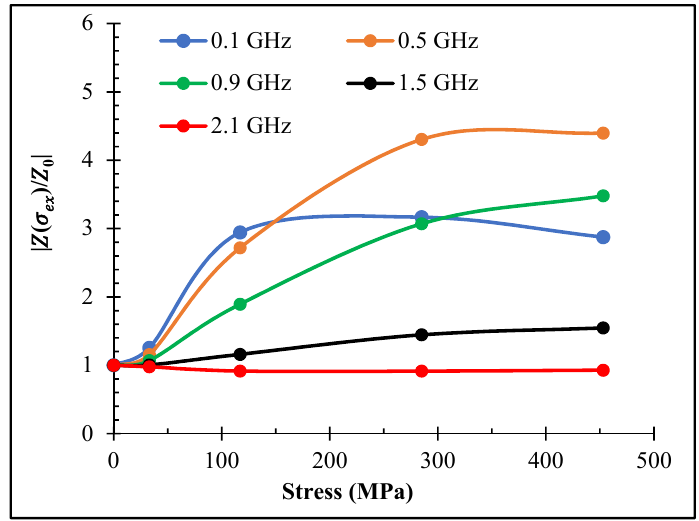
Figure 13. Stress dependence of MI at zero field Z ( H = 0) for amorphous Co 71 Fe 5 B 11 Si 10 Cr 3 mi- crowires (sample No2) after DC current annealing at 60 mA for 30 min at different frequencies. | Z ( σ ex ) / Z | = | Z ( H = 0, σ ex ) / Z ( H = 0, σ ex = 0 ) . σ ex is the applied 0